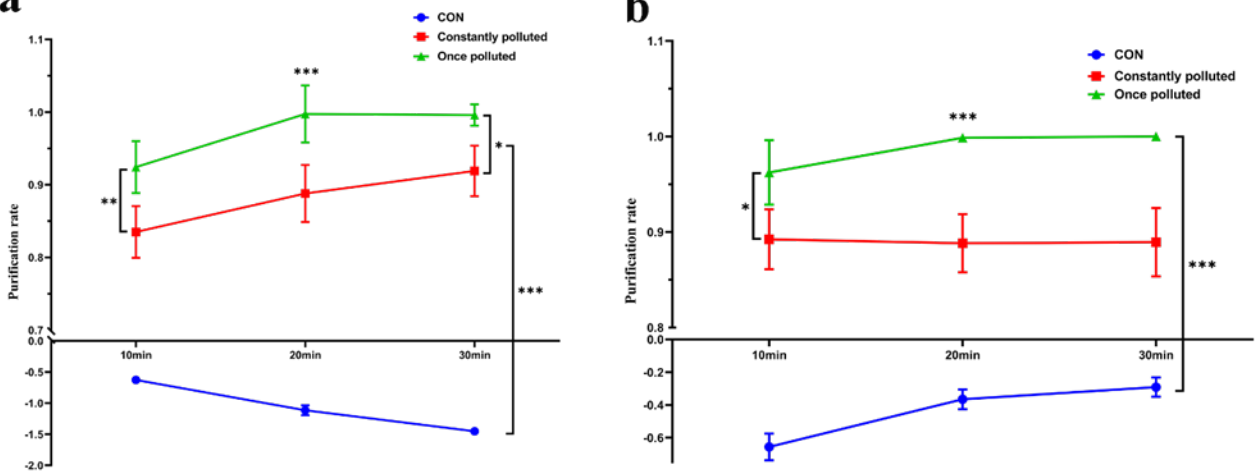
Figure 5. Comparison of the effects of combined application on the removal of S. albus ( a ) and influenza virus ( b ) from constantly and once-polluted environments. The statistical differences between the items are analyzed. (*: p < 0.05; **: p < 0.01; ***: p < 0.001).